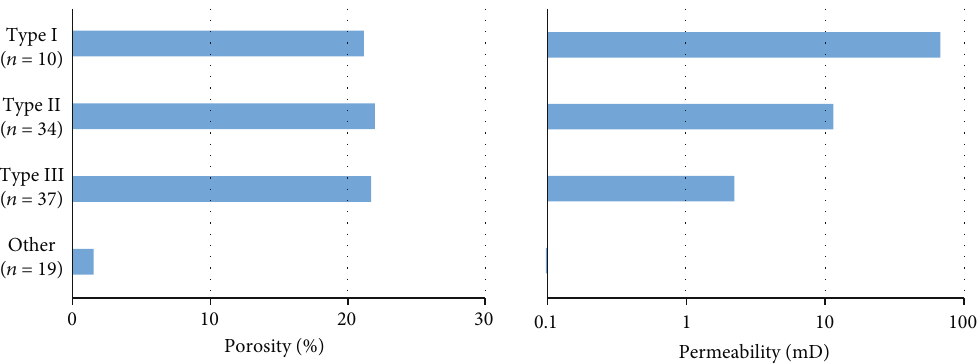
Figure 8: Average petrophysical property distribution of three pore throat structure types.